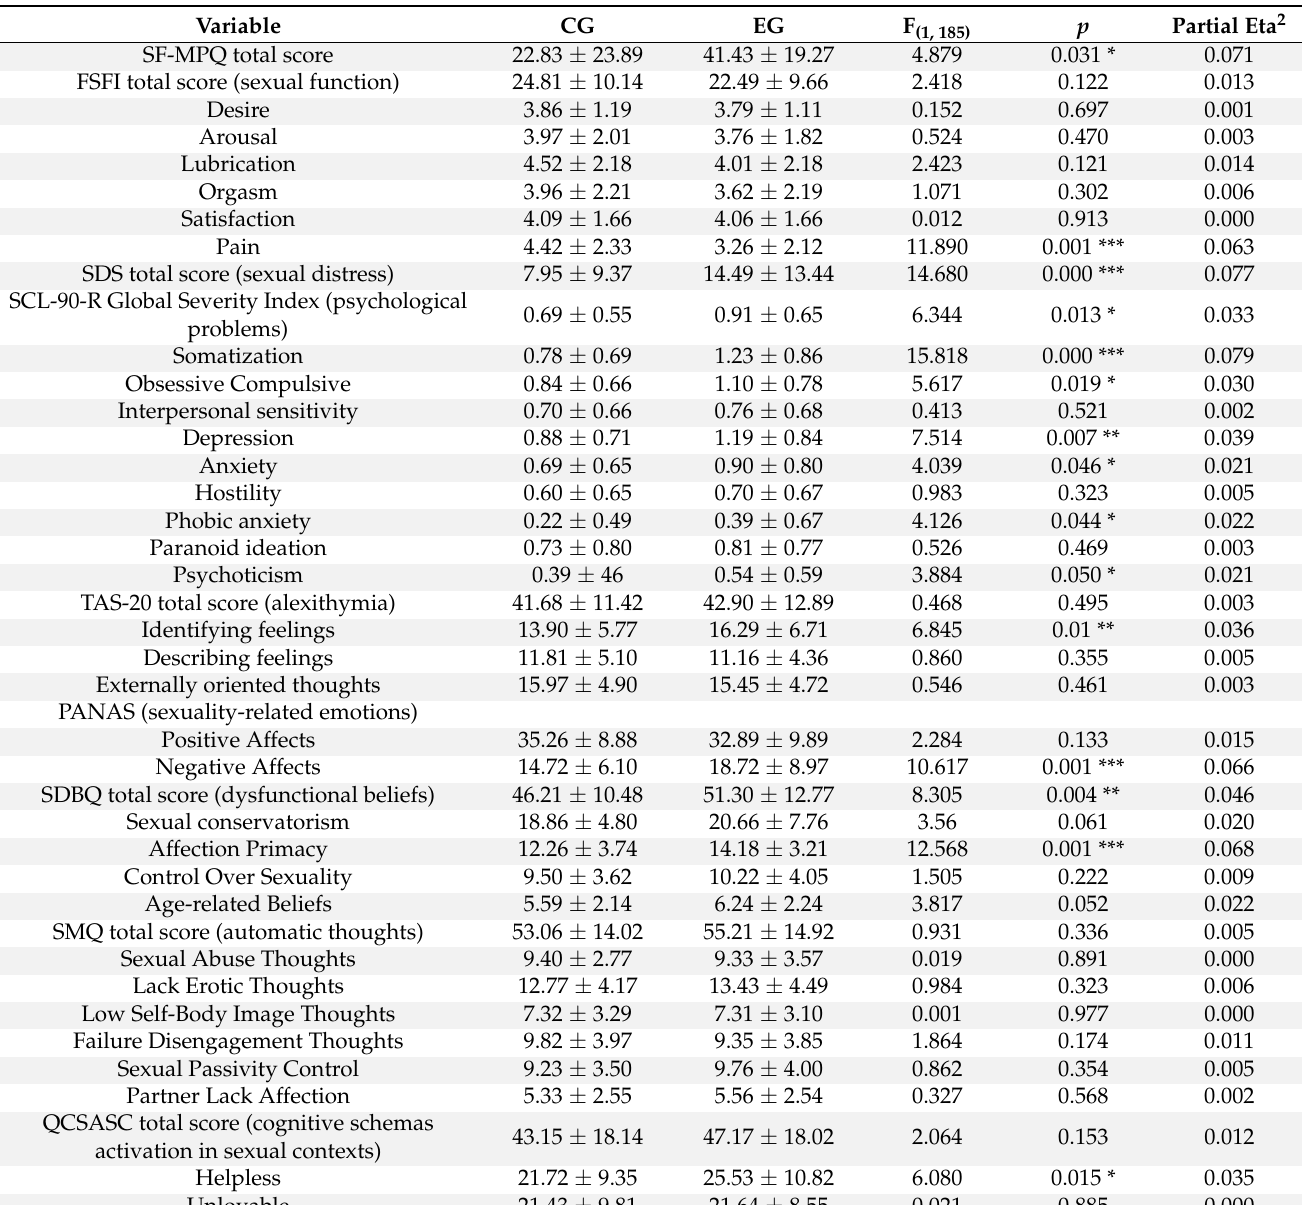
Table 2. Differences between women with and without genital pain: one-way ANOVAs and